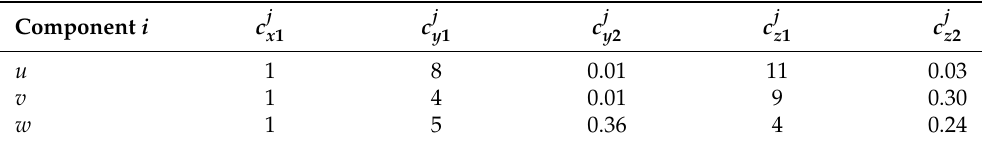
coefficients are eastimated by least-square fit of Equation (13).